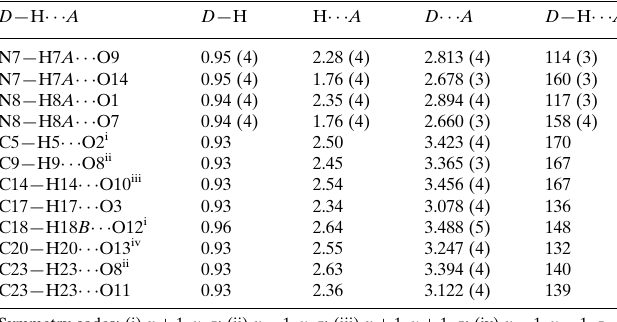
Hydrogen-bond geometry (A˚ , (cid:4)